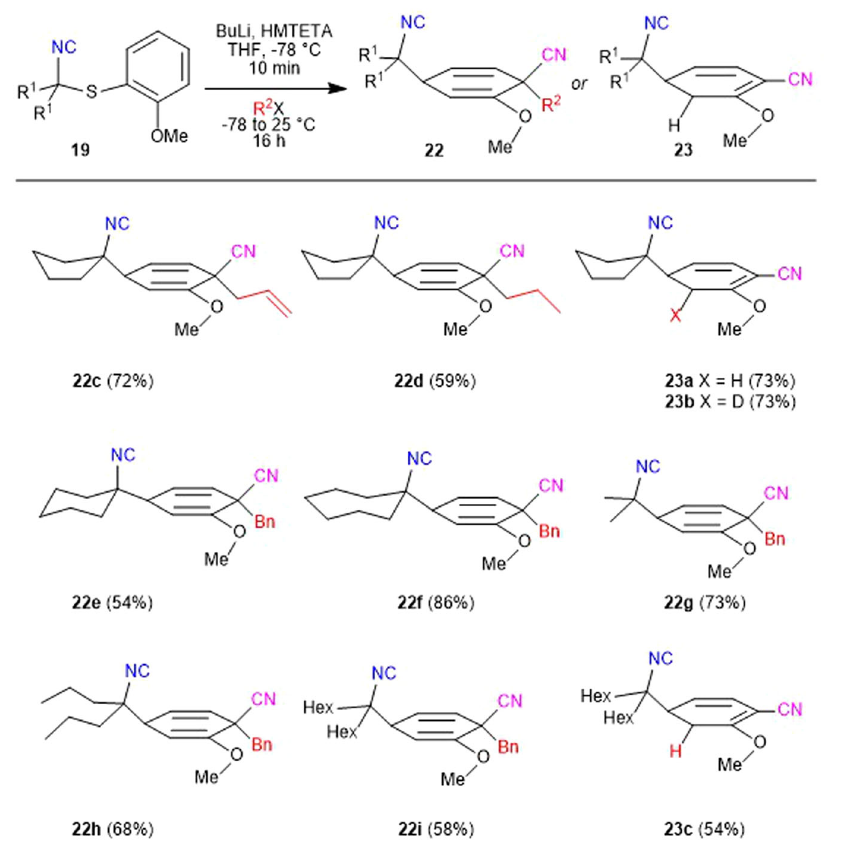
Fig. 4 | Scope of the dialkylAsmic dearomatization. All yields are of pure, isolated materials following chromatographic puri fi